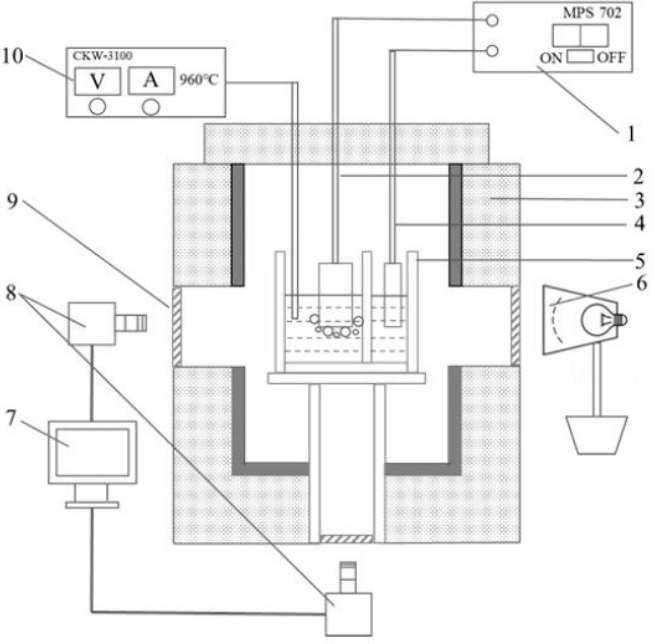
Figure 1. Schematic of the bottom- and side-view see-through cell. 1—DC power supply, 2—anode, 3—furnace, 4—cathode, 5—transparent quartz crucible, 6—light source, 7—computer for data collection, 8—cameras, 9—quartz window, 10—temperature controller.